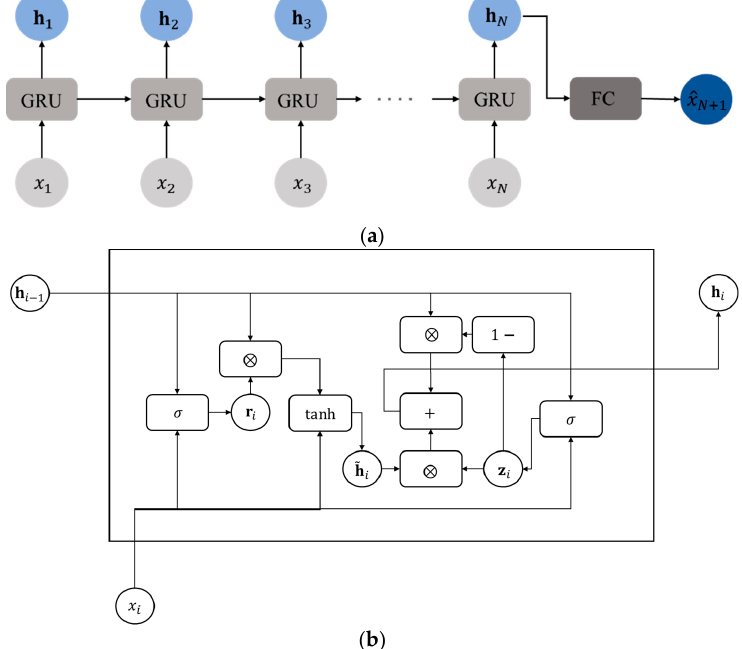
Figure 1. The schematic diagram of GRU neural network and its cell: ( a ) typical GRU neural network; ( b ) schematic diagram of GRU neural network and its cell. The structure of the GRU cell is shown in Figure 1b, where 𝐫 (cid:3036) , 𝐳 (cid:3036) , 𝐡(cid:4634) (cid:3036) , ⊗ , tanh , 𝜎 denote reset gate, update gate, candidate hidden state, element-wise multiplication, hy- perbolic tangent function, and sigmoid function, respectively. The information flow inside the cell can be written as follows [40]: